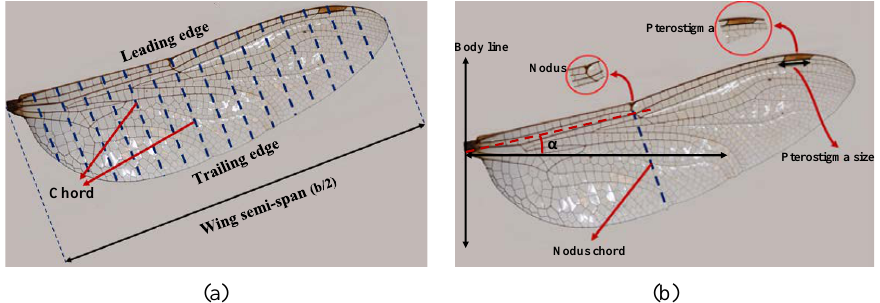
Figure 1. Dragonfly wing geometry definition: geometrical parameters ( a ) and dragonfly wing geometry definitions nodus and pterostigma ( b ).